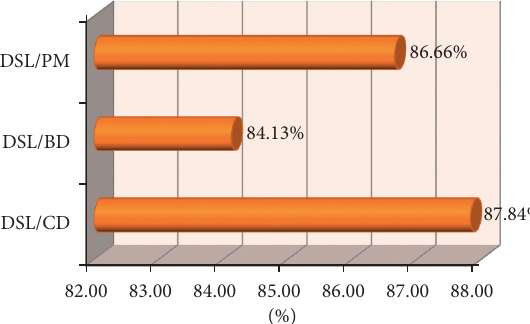
Figure 7: TR of the briquettes with different